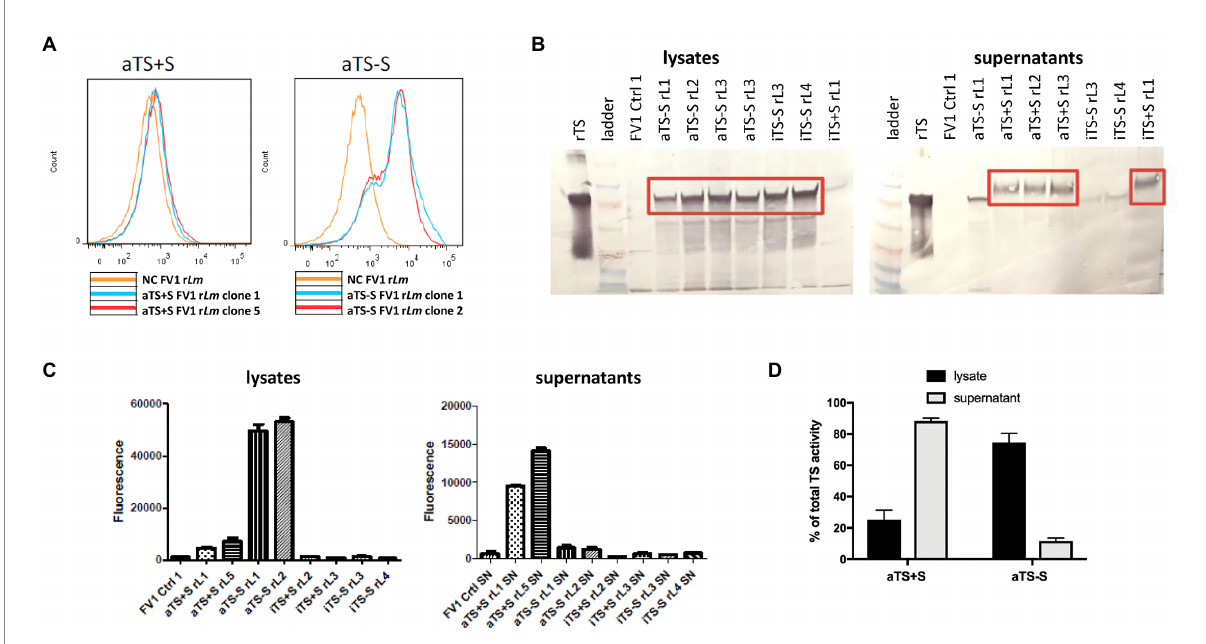
FIGURE 2 Screening of TS-expressing recombinant FV1 Leishmania major parasites. (A) After transfection, intracellular TS could be detected by flow cytometry in parasites expressing nonsecreted TS (aTS − S), but not in parasites expressing the secreted form (aTS+S), confirming appropriate deletion or maintenance of the signal sequence. (B) As expected, TS protein was detected by Western Blot analysis in the lysates of parasites expressing nonsecreted protein (aTS − S and iTS − S), and in the supernatants of parasites expressing secreted protein (aTS+S and iTS+S). (C) Significantly higher levels of enzymatic activity were detected in the lysates of parasites expressing active non-secreted TS (aTS − S) compared to the lysates of parasites expressing inactive non-secreted TS (iTS − S). TS enzymatic activity was similarly higher in the supernatants of parasites expressing active secreted TS (aTS+S) compared to supernatants of those expressing inactive secreted TS (iTS+S). (D) Some residual TS activity could be detected in the lysates of aTS+S parasites, and in the supernatants of aTS − S